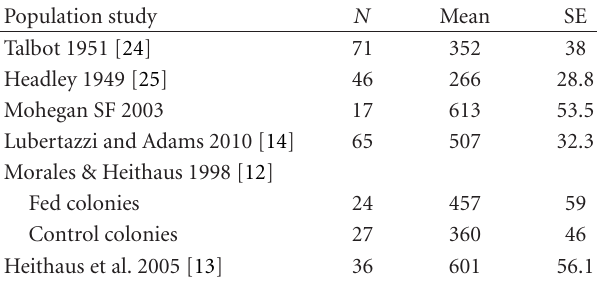
Table 2: The average number of workers per colony for various populations of rudis -group